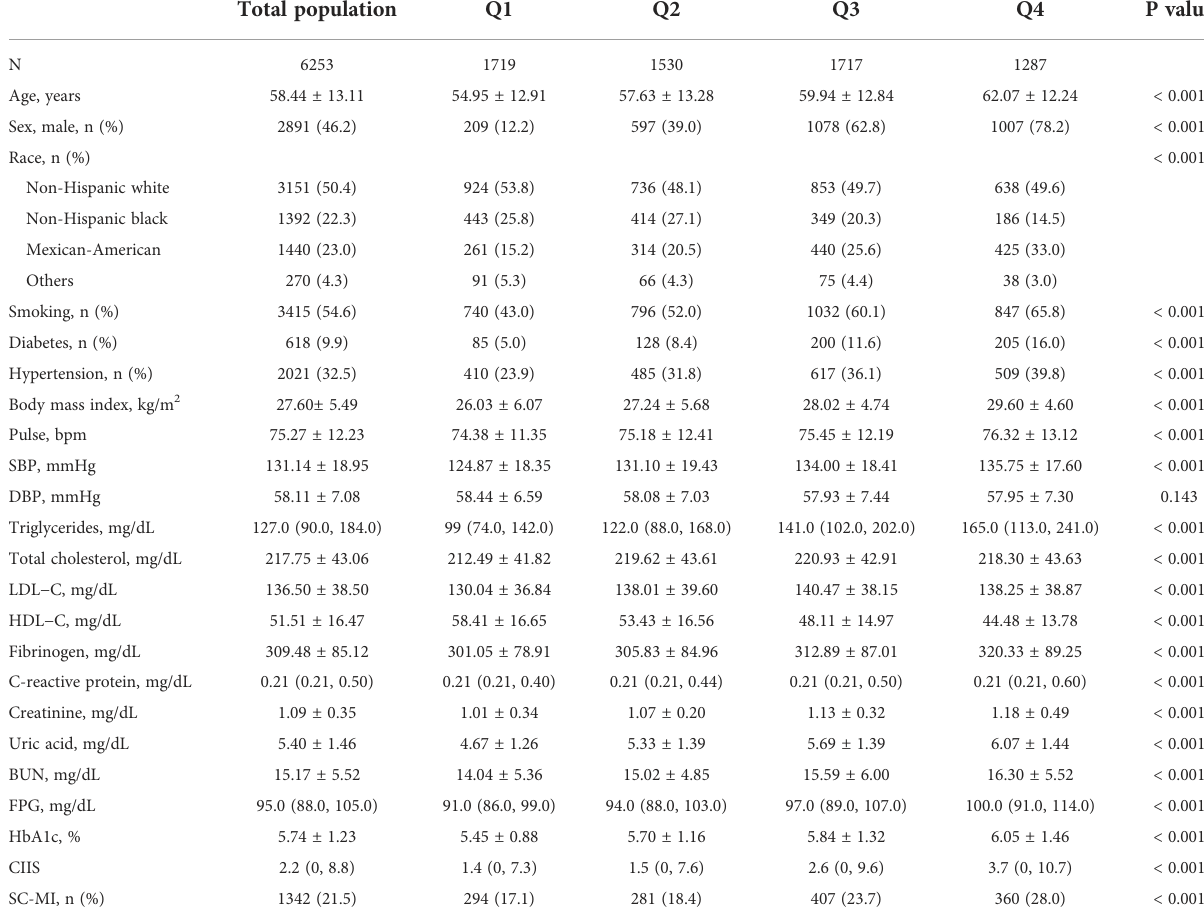
TABLE 1 Baseline characteristics of participants strati fi ed by the quartile of the